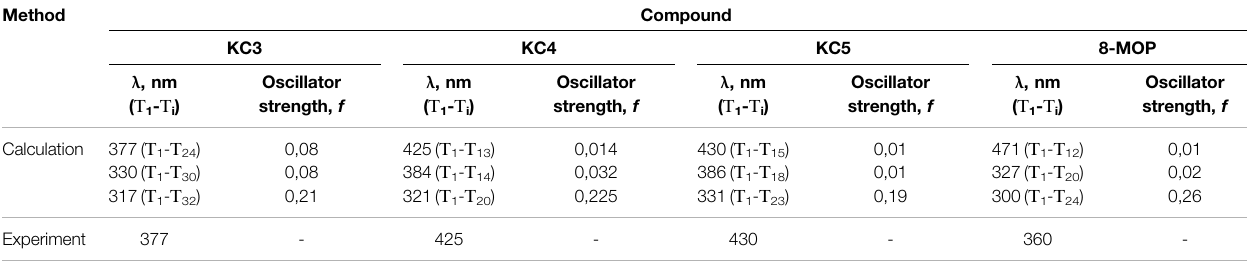
TABLE 3 | Triplet-Triplet absorption spectra of several compounds.